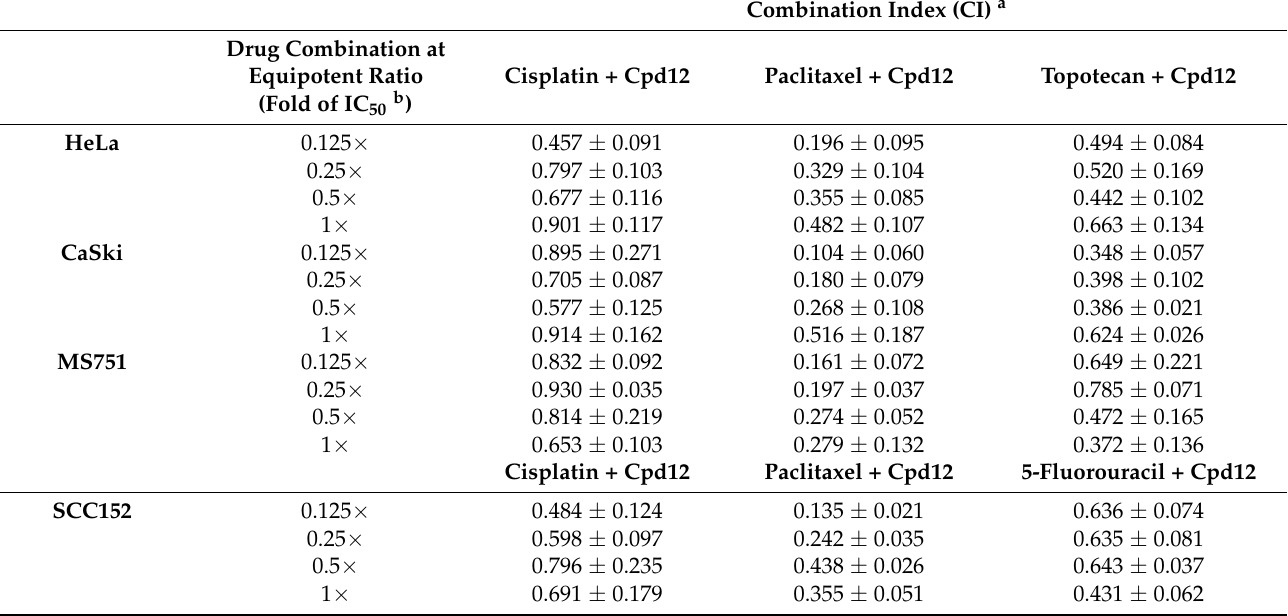
Table 1. Analysis of the effect of the drug combination on HPV-positive cervical and head-and-neck cancer cells